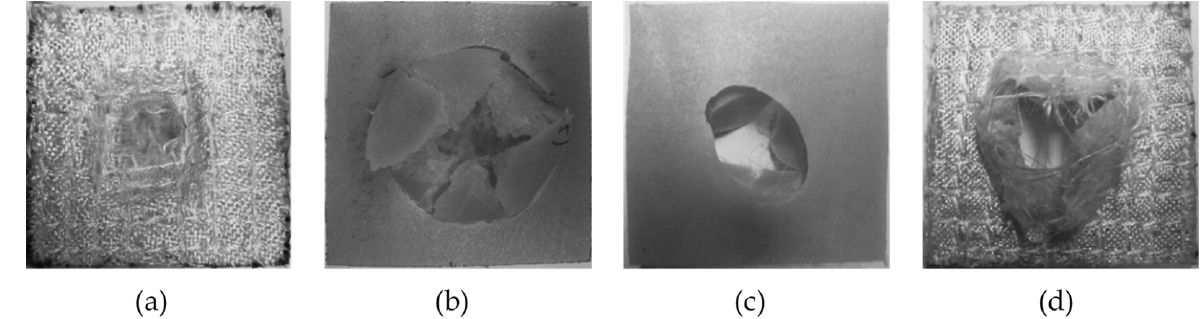
Figure 15. Impact samples on PAGF-PA86 composite. ( a ) Impact face on sample with ejector side impact. ( b ) Opposite impact face on sample with ejector side impact. ( c ) Impact face on sample with injection side impact. ( d ) Opposite impact face on sample with injection side impact.